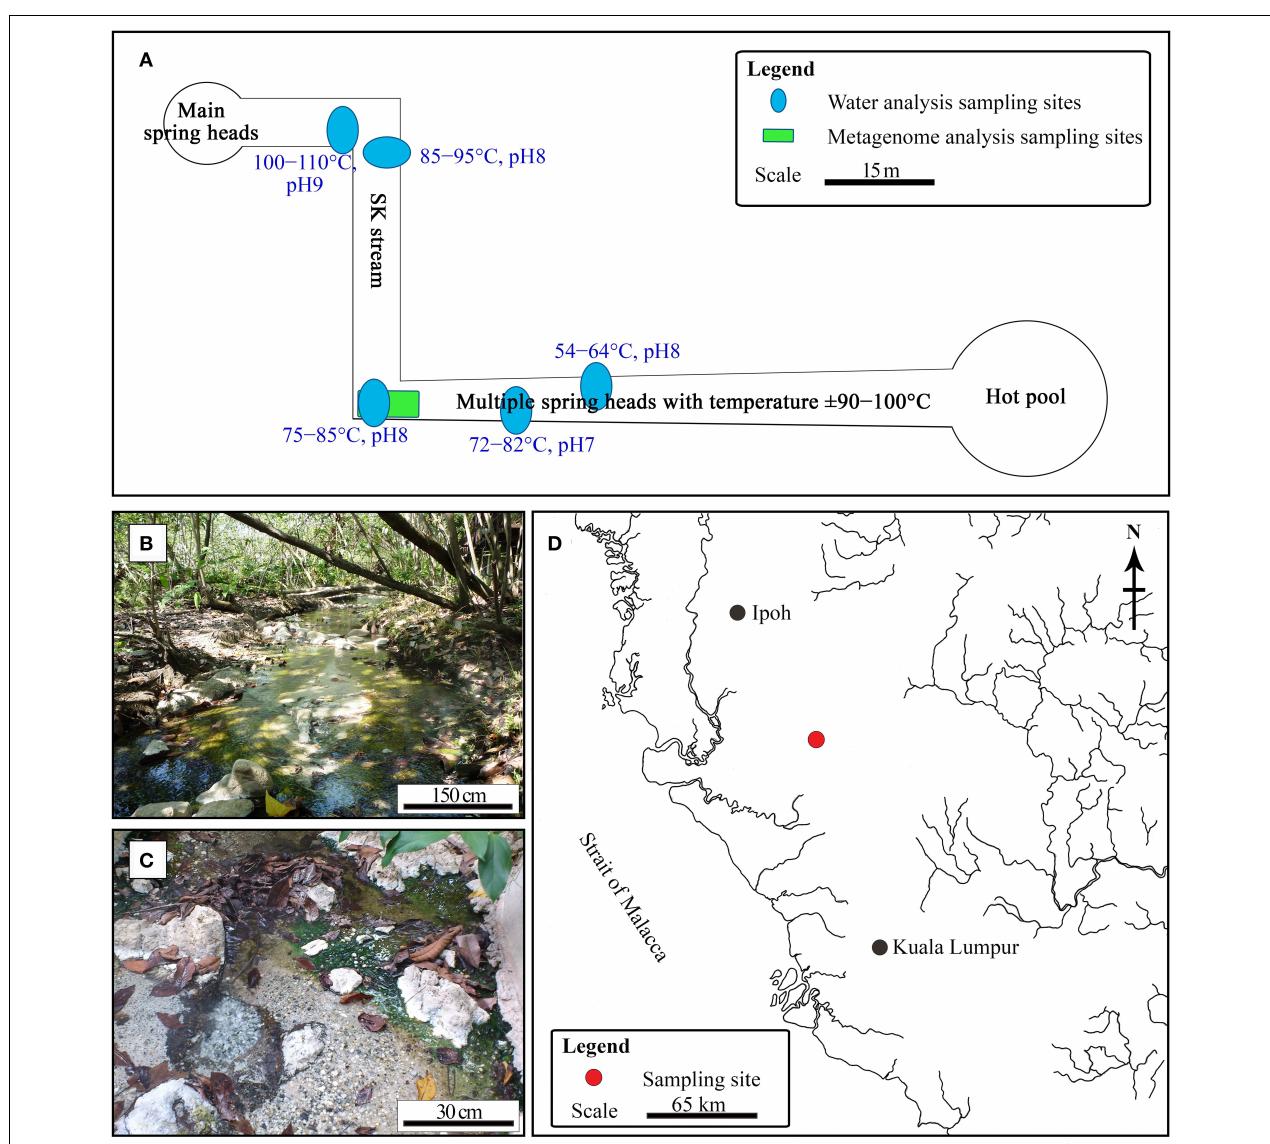
FIGURE 1 | Sungai Klah hot spring. (A) Illustration of pH, temperature, and sampling sites for water and metagenomic analyses. (B,C) Photographs of the SK hot spring. (D) The Sungai Klah hot spring is located in Perak, Malaysia.